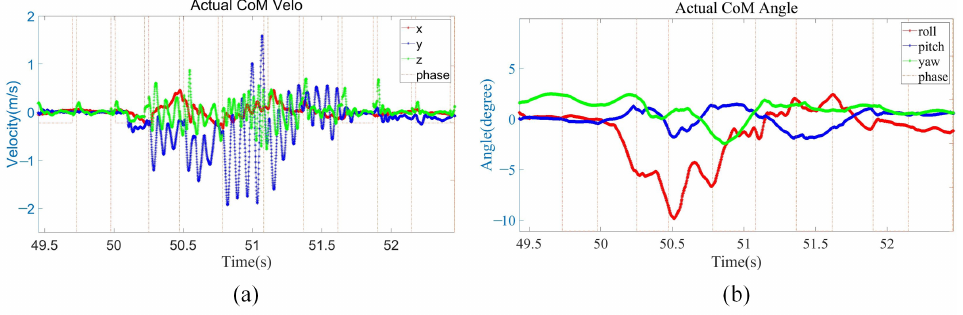
Figure 6. Disturbance recovery experiment data. ( a ) Robot body velocity. The red, blue, and green lines present the robot body velocity of x-, y-, and z-directions; ( b ) robot body angle. The red, blue, and green lines present the robot body roll, pitch, and yaw